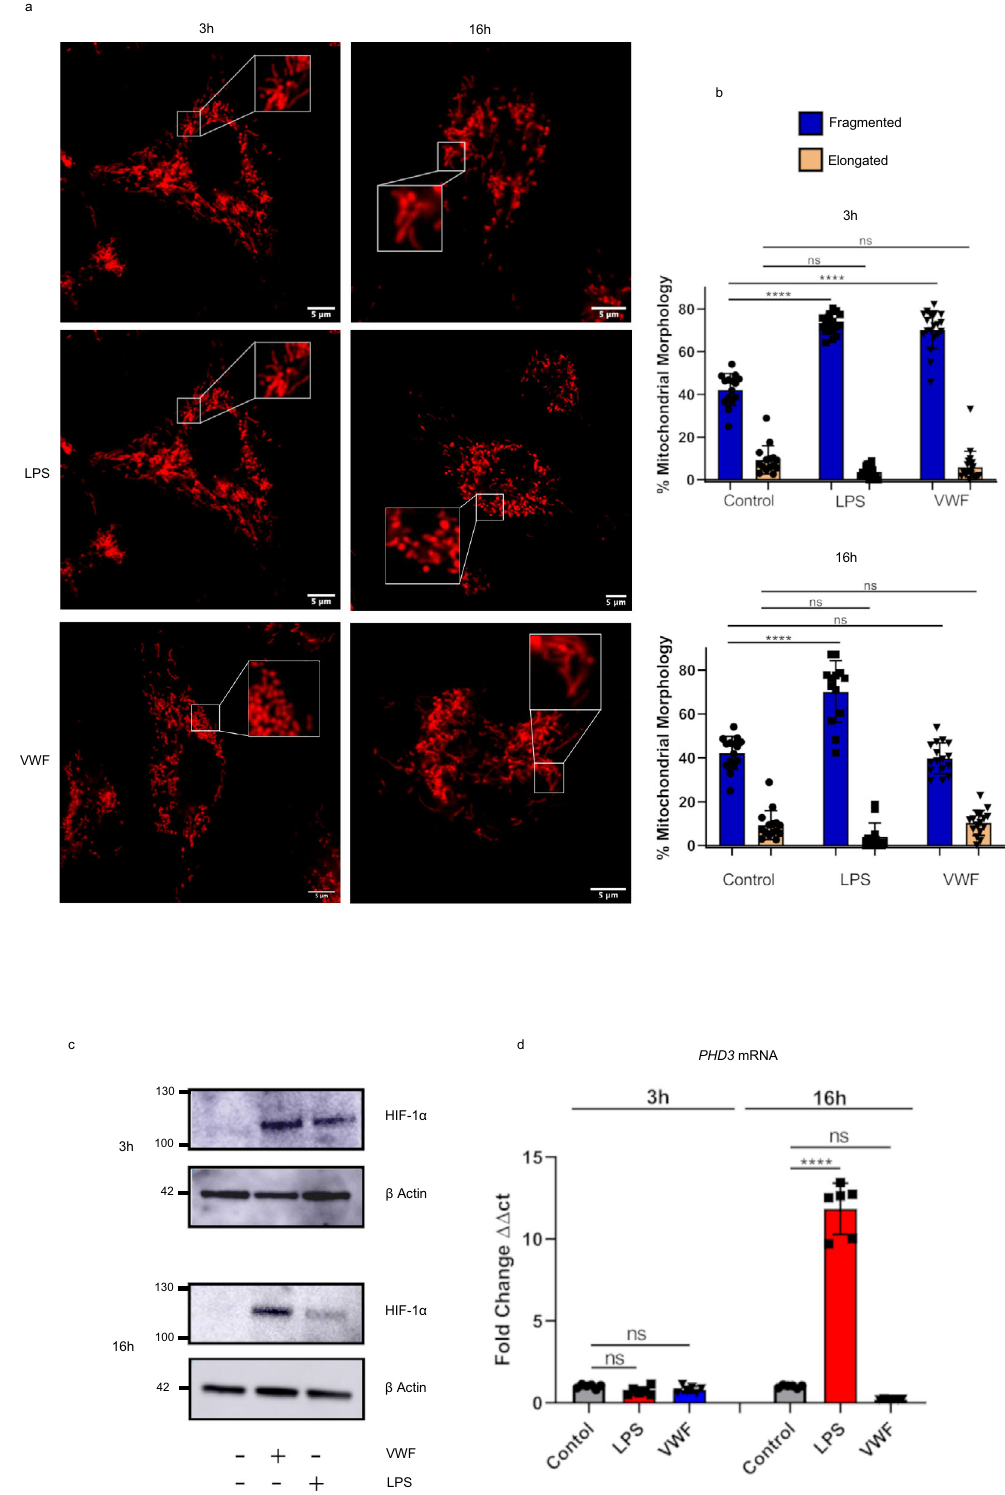
Fig. 6 | VWF in fl uences mitochondrial dynamics and up-regulates HIF-1 α expression.a , b MurineBMDMswereincubatedinthepresenceorabsenceofpd- VWF (10 μ g/ml) or LPS (100ng/ml) for 3 or 16h and mitochondrial morphology assessed using Mitotracker and scanning confocal live cell imaging as detailed in theMaterialsandMethods.Aminimumof20imagesincluding ≥ 60mitochondria per cell were analyzed per treatment. Following 3h stimulation with either VWF or LPS, a signi fi cant increase in mitochondrial fragmentation consistent with an increase in glycolysis was observed ( p <0.01 and p <0.001 respectively). Although a signi fi cant increasein mitochondrialfragmentation was still